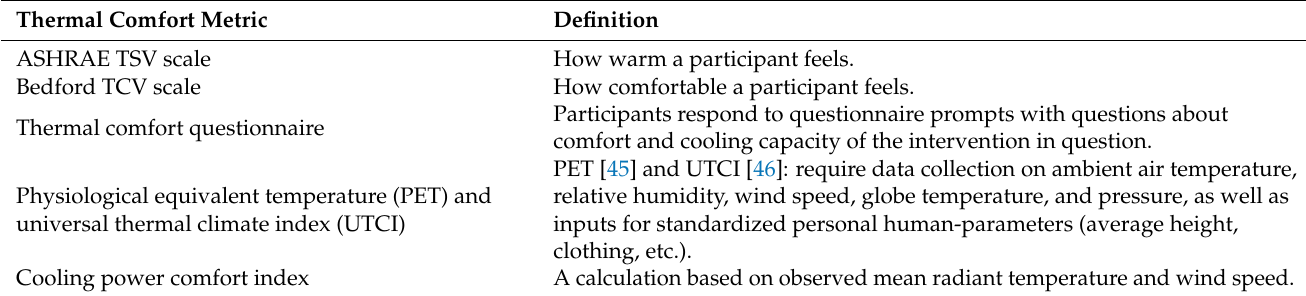
Table 5. Thermal comfort metrics and definitions, as provided in the literature